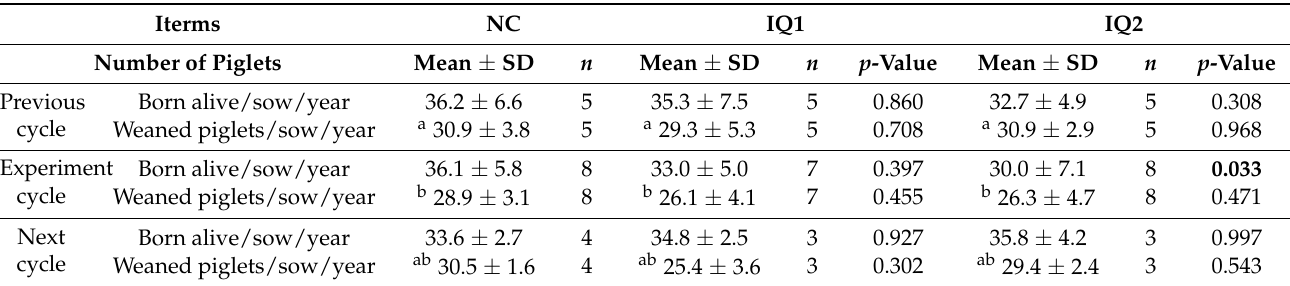
Table 5. Sows’ reproductive performance during the cycle prior to the experiment, during the experiment, and the cycle after the experiment was recorded. Sows received either a basal diet (NC), or supplementation with isoquinoline alkaloids (IQ) during gestation and lactation (IQ1), or only during the lactation period